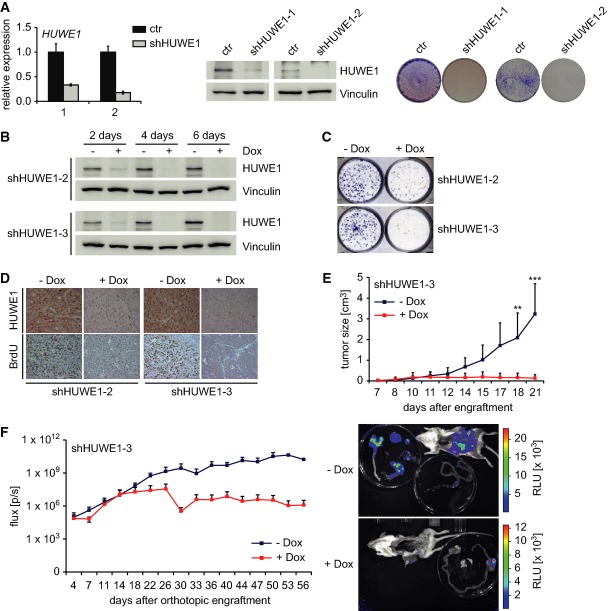
Effect of HUWE1 depletion on growth and tumor formation of colorectal cancer cellsThe left panel shows RQ–PCR assays documenting expression of HUWE1 in
Ls174T cells after infection with either control or two different shRNAs targeting HUWE1. The middle
panel shows an immunoblot documenting expression of HUWE1 in these cells. Vinculin was used as
loading control. The right panel shows a colony formation assay of Ls174T cells expressing control
or shRNAs targeting HUWE1 (n = 3; unless otherwise indicated,
n indicates the number of animals or independent biological repeat experiments in
the following legends).Ls174T cells expressing doxycycline-inducible shRNAs targeting HUWE1 were treated with
1 μg/ml doxycycline or solvent control. Cells were harvested at the indicated time
points, and immunoblots of the lysates were probed with antibodies against HUWE1 or Vinculin as
loading control.Colony formation assay of Ls174T cells expressing doxycycline-inducible shRNAs targeting HUWE1.
Cells were cultured for 10 days in the presence or absence of 1 μg/ml
doxycycline as indicated. Colonies were stained with crystal violet.Immunohistochemistry documenting expression of HUWE1 and incorporation of BrdU in subcutaneous
tumors of Ls174T cells expressing doxycycline-inducible shRNAs targeting HUWE1. Seven days
after start of doxycycline treatment, mice were injected with BrdU. 1 h after injection,
tumors were dissected for immunostaining.Subcutaneous tumor growth during doxycycline treatment. The experiment was performed as described
in (D). Seven days after engraftment, tumors became palpable and doxycycline treatment was
started. Tumor growth was followed for 2 weeks. Data are presented as
mean + standard deviation (SD) (n = 5).
P-values were calculated using Student's t-test
(**P-value < 0.01,
***P-value < 0.001).Growth of orthotopic Ls174T tumors grafted in the cecum of immunocompromised mice during
doxycycline treatment. Doxycycline treatment was started when all the mice showed an abdominal
luciferase signal (14 days after engraftment), and tumor growth was followed for
six weeks (left panel). Data are represented as mean + SD
(n = 3 for most time points, see Supplementary Fig S2C). At
the end of the experiment, mice were dissected and luciferase activity was assessed in different
organs. One example is shown in the right panel. flux
[p/s] = photons per sec. RLU = relative
light units.